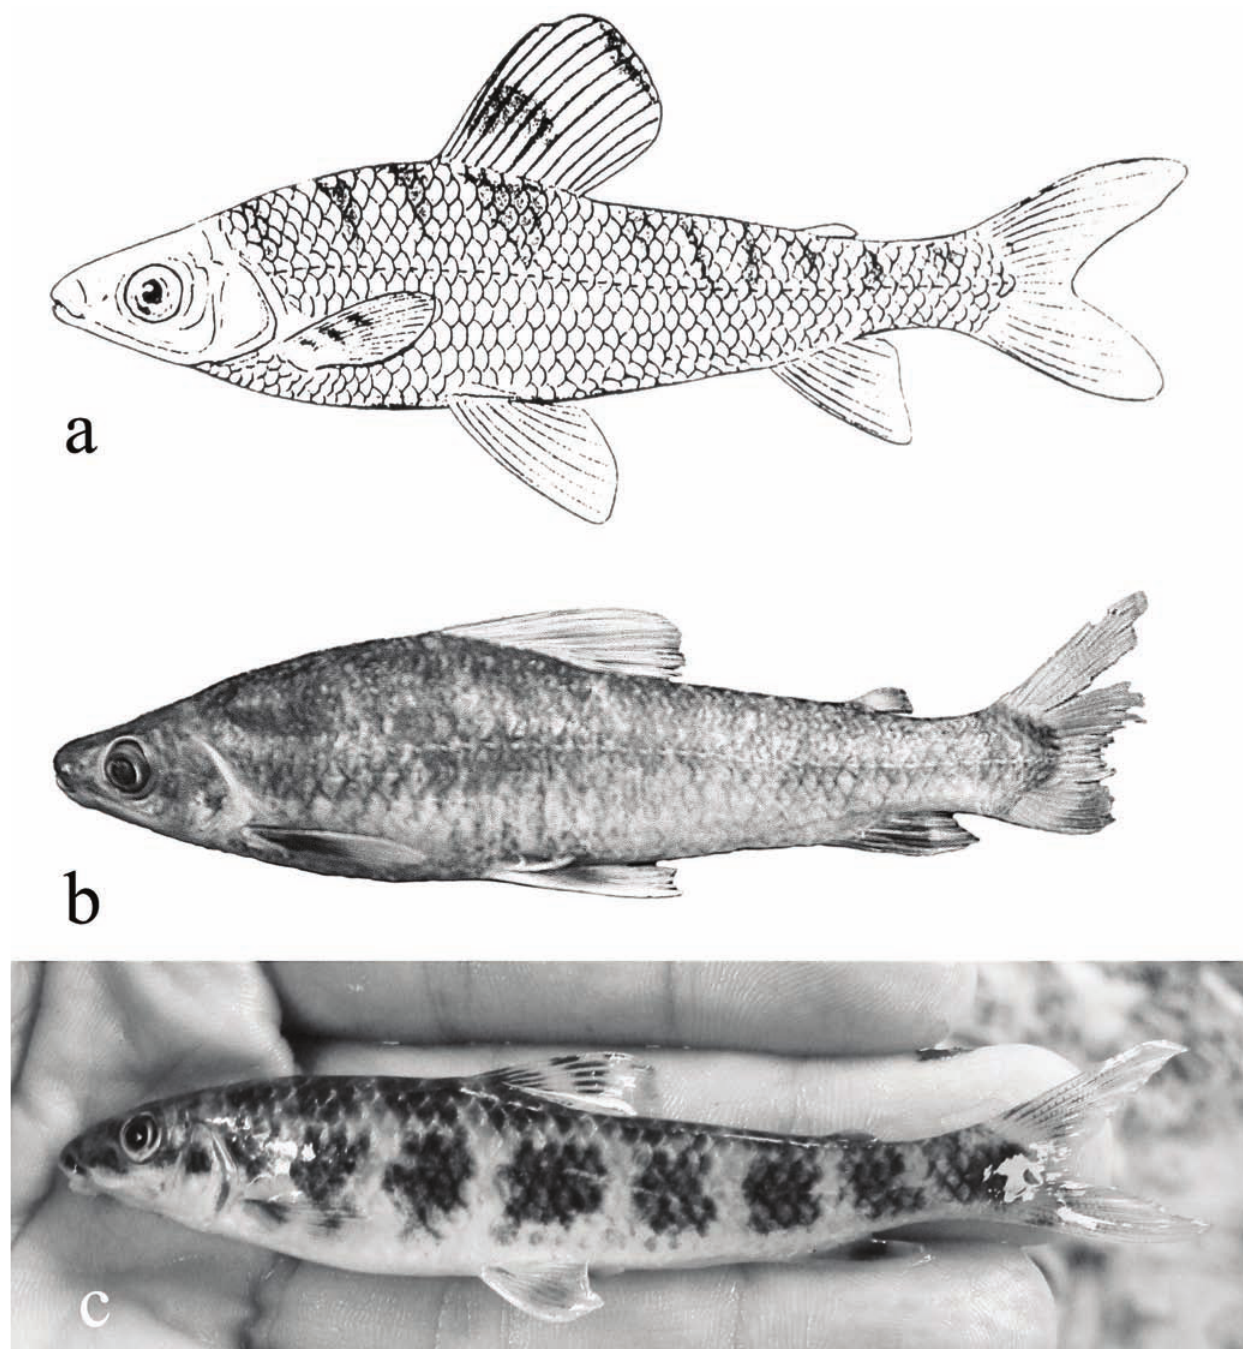
Fig. 4. (a) Roetter’s drawing of Leporinus jamesi based on holotype MCZ 20439, 73.8 mm SL, rio Solimões at Manacapuru, and published in Borodin (1929: plate 9); (b) Leporinus jamesi , MUSM 29750, 132.1 mm SL, Peru; (c) Leporinus octomaculatus , upper rio Paraguay basin, photographed live by Claudio